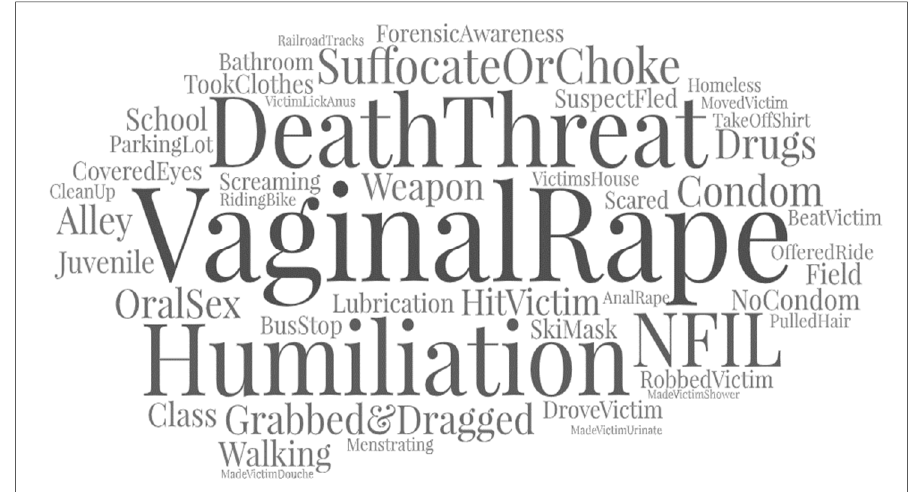
Figure 1. Word Cloud of the Police Reports for Offender’s 22 Rapes.